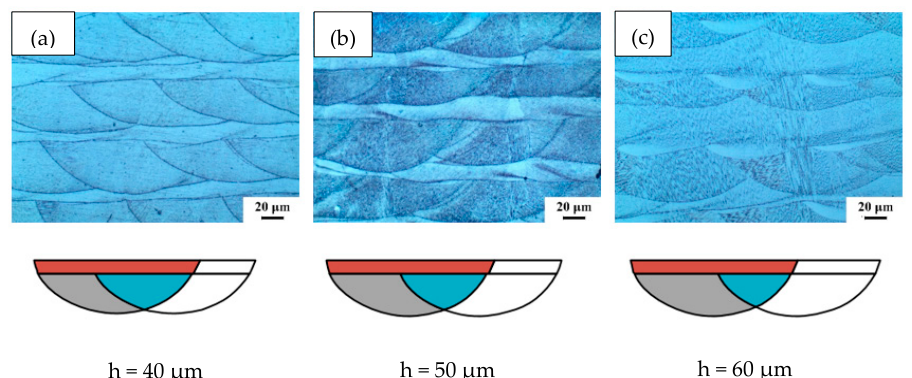
Figure 10. Schematic diagram of metallographic structure and molten pool overlap for different scan line spacings, ( a ) 0.04 mm; ( b ) 0.05 mm; ( c ) 0.06